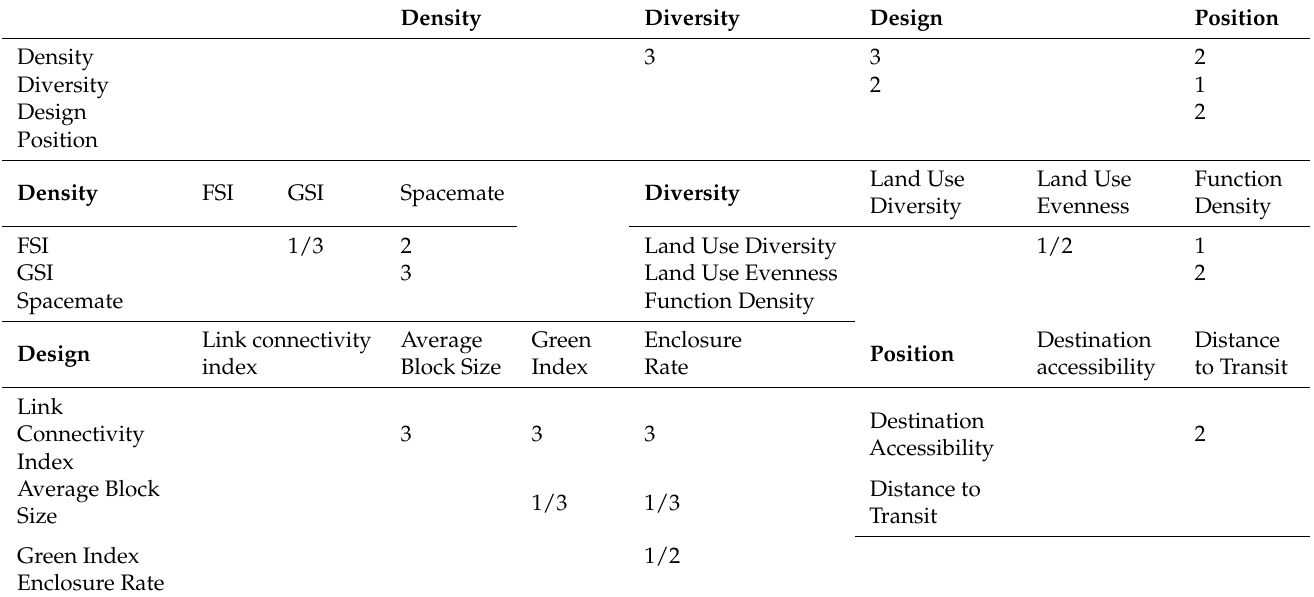
Table A1. Expert